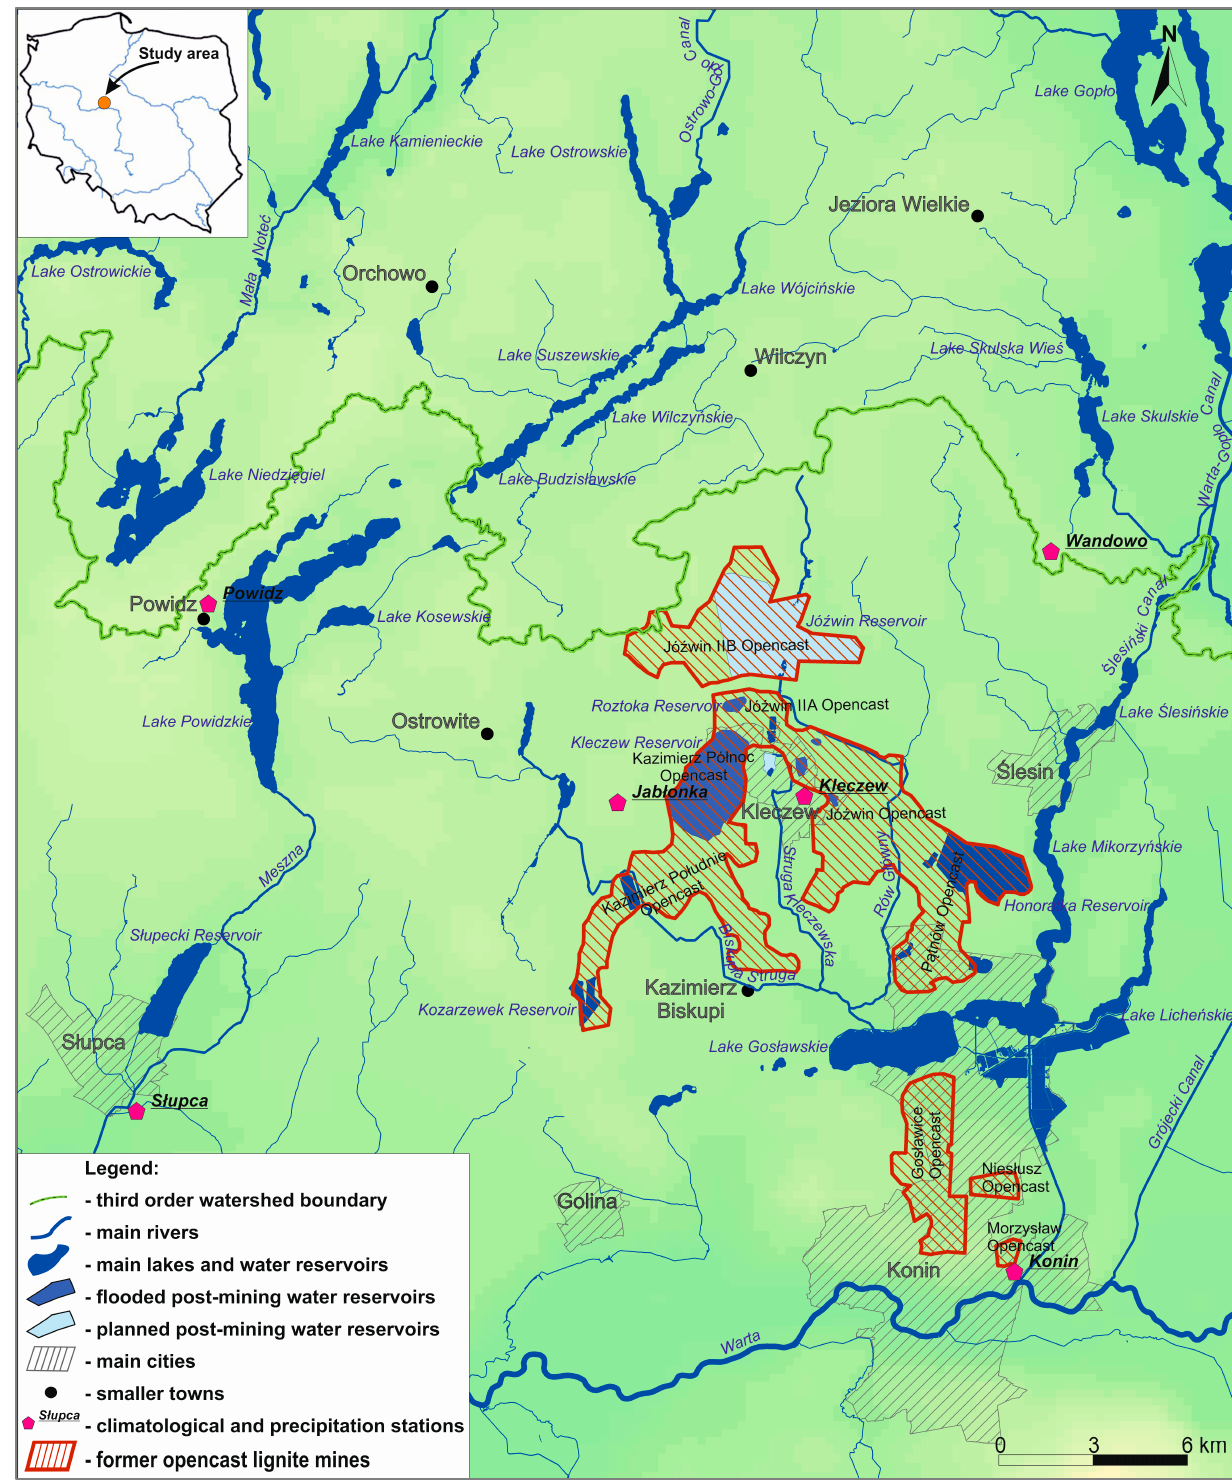
Figure 1. Location of the study area.